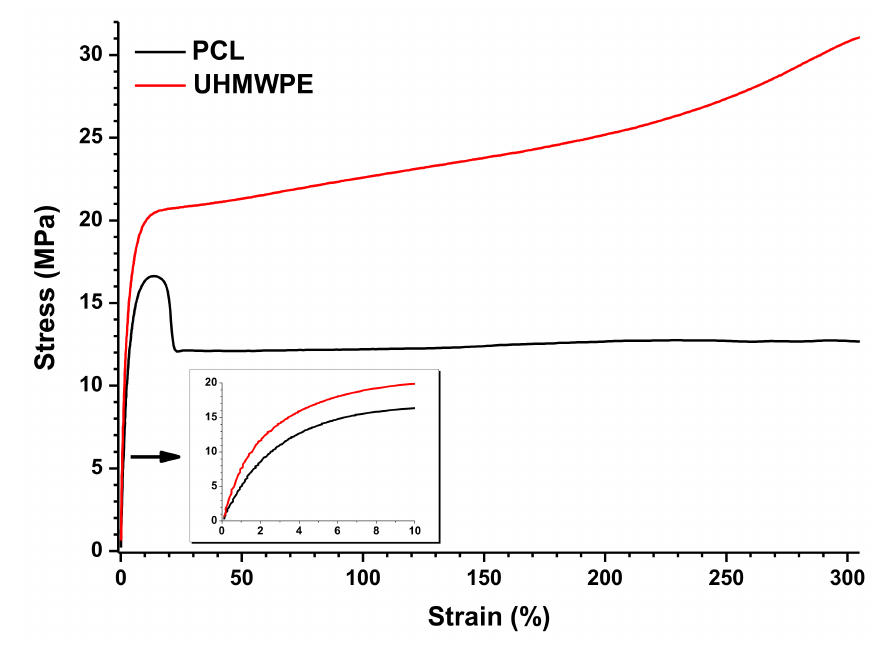
Figure 8. Tensile tests of PCL and